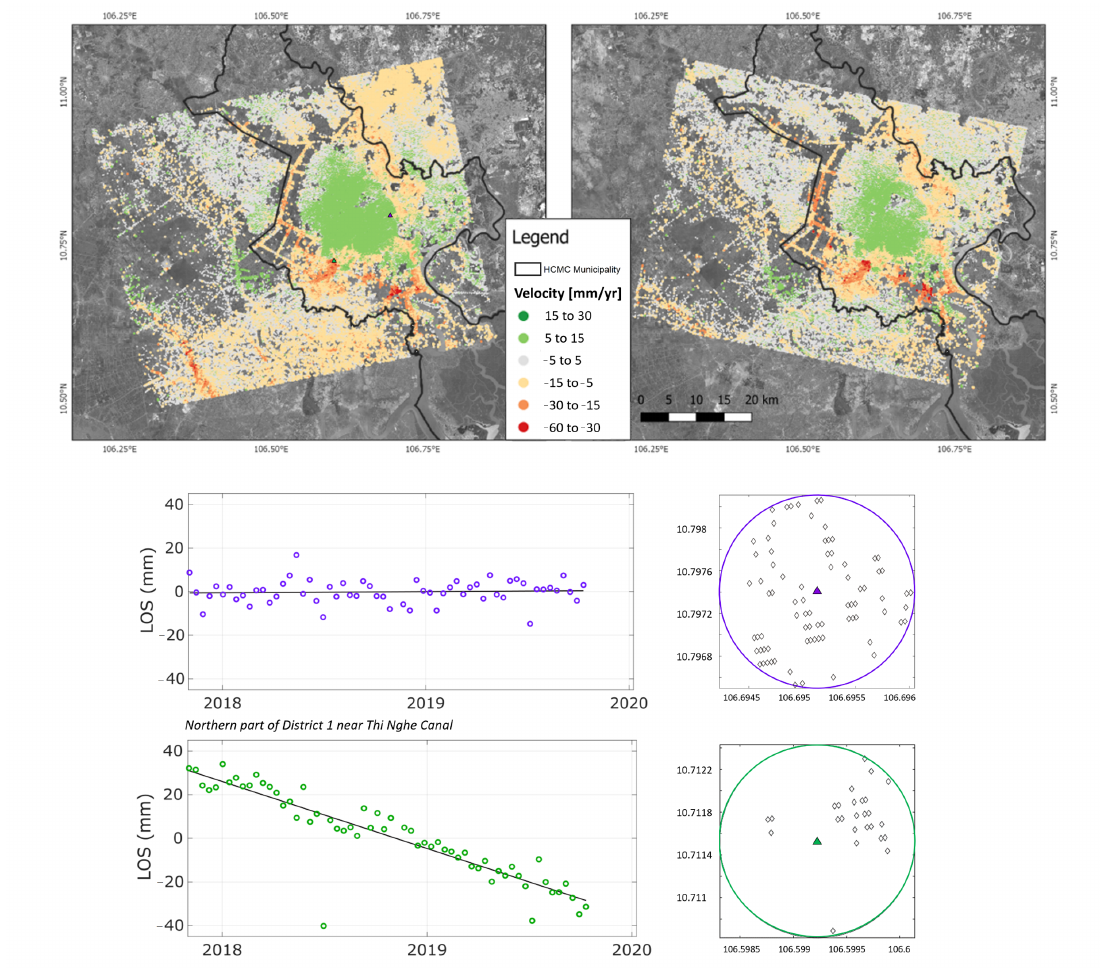
Figure 4. Average LOS displacement for for both ascending ( left : track A128) and descending ( right : track D18) tracks between 11/2017 and 10/2019 ( top ) and time-series plot for two selected sites ( bottom